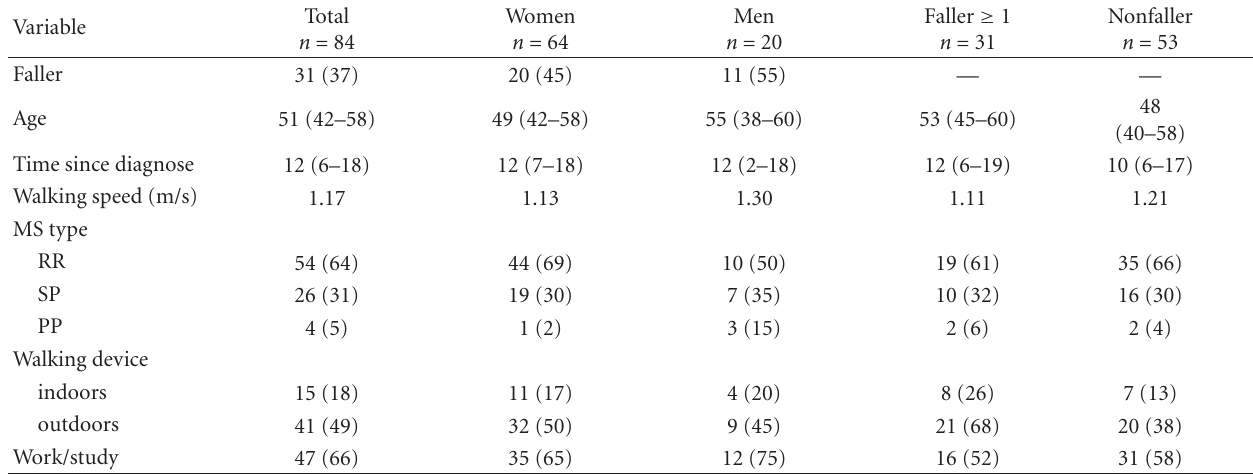
Table 1: Demographic data. Medians and interquartile ranges (25–75%) presented for age and time since diagnose, mean for walking speed, otherwise frequency and percentage.